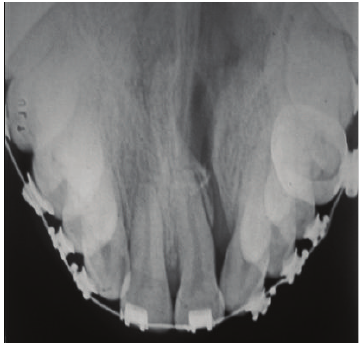
Figure 1: Occlusal radiograph. You can see the cleft through the palate compromising alveolar ridge and hard palate.